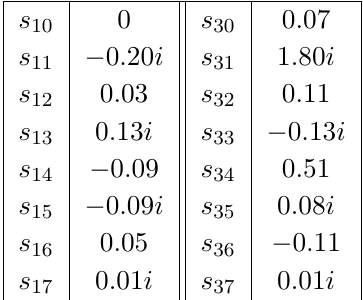
Table 4 . The fitting parameters at T = 0 . 175